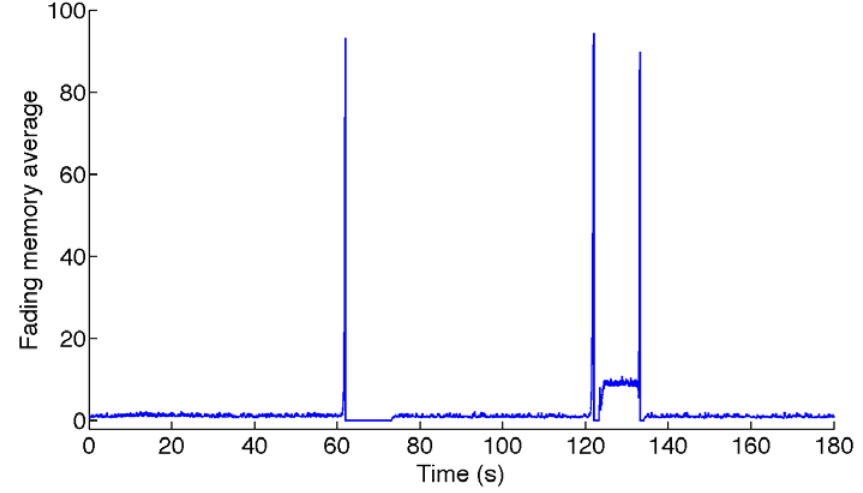
Figure 2. Fading memory average used for switching from the quiescent state model to the higher-order state model in the VSD-EKF (static test).